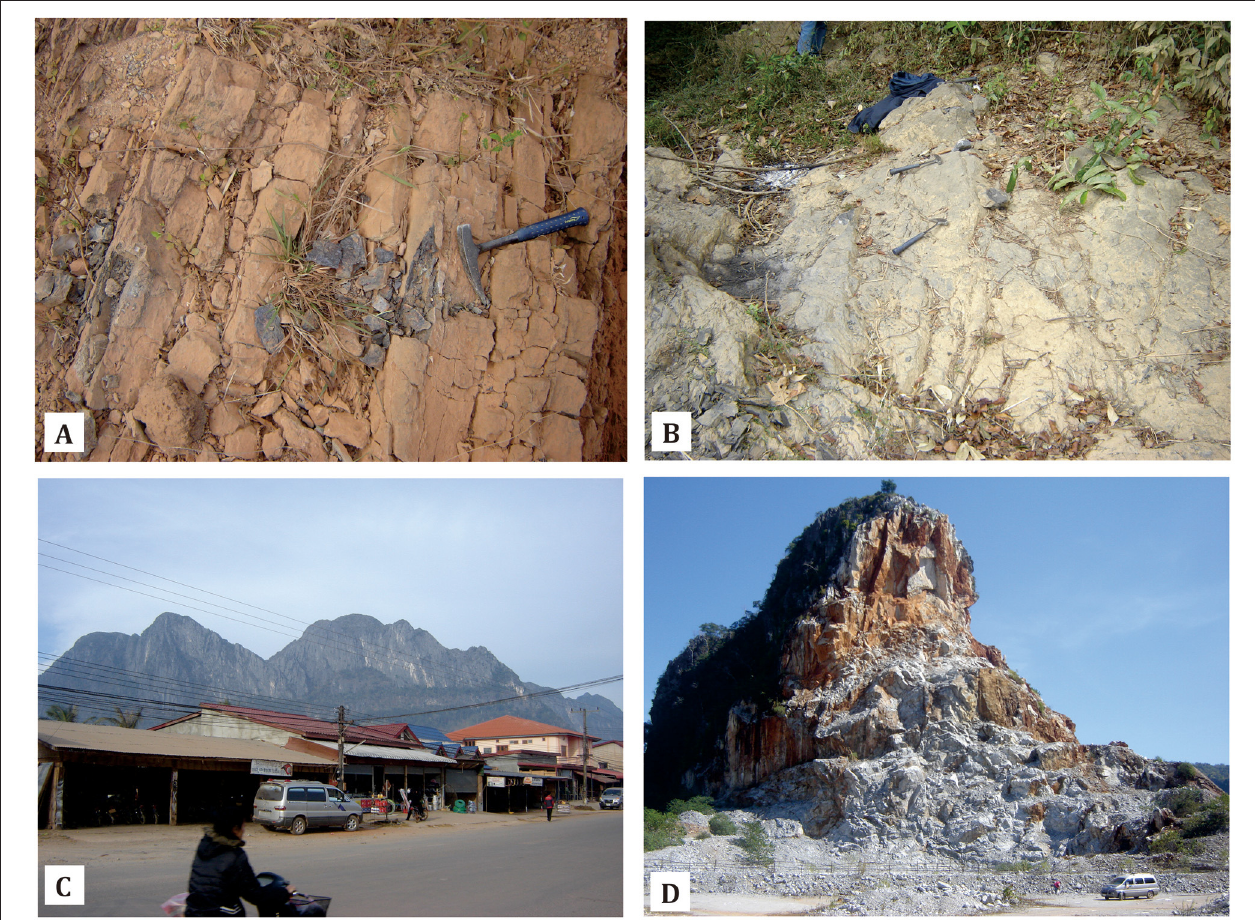
FIGURE 12 | Field photographs of Boualapha Formation and Khammouan Group from central Laos. (A) Outcrop of carbonaceous limestone belonging to the Boualapha Formation north of Boualapha Town. (B) Close-up of (A) , (C) Large outcrop of limestone of the Khammouan Group north of Lak Xao Town. (D) Limestone belonging to the Khammouan Group, south of Lak Xao Town, central Laos [see Figure 4 and Thassanapak et al. (2012) for localities]. Lak Xao township is shown as LX in Figure 4 .